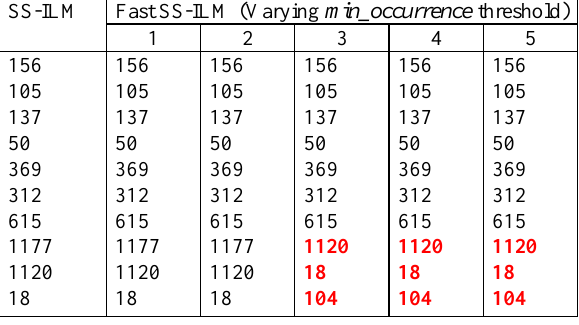
Table 2. Top 10 socially important locations for algorithms and for min_occurrence threshold values of 1 to